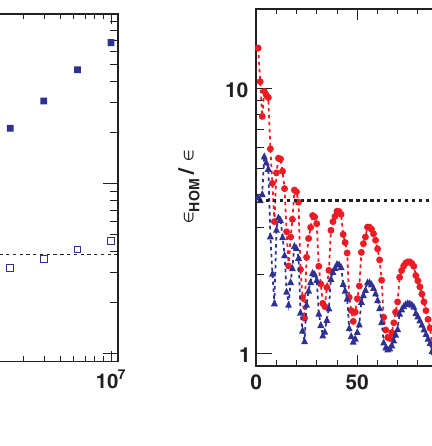
FIG. 14. Longitudinal phase space increase as a function of the cavity, where the HOM at the 8th machine line is located for different damping. The average increase due to rf errors is indicated with the dashed line. An oscillating phase space increase is observed, which decreases further downstream in the linac. The oscillation is due to the used injection noise ¼ 2817 : 6 MHz , ð R=Q Þ ¼ 1 (cid:2) , N ¼ 1 , pattern. Settings: f ML ML other cavities use default HOM configuration, see Table